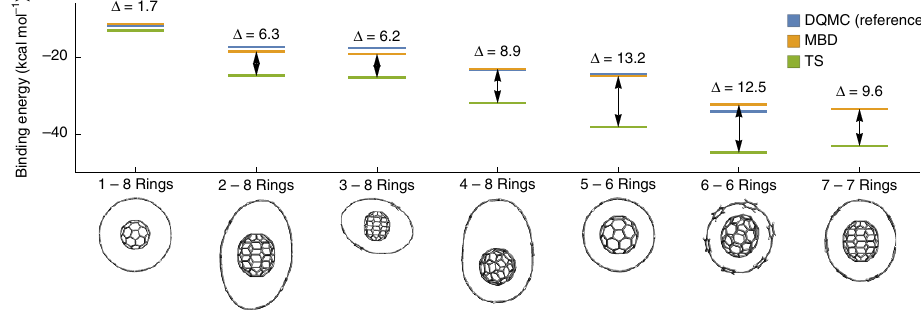
Figure 5 | Interaction energies of C70 in [ N ]cycloparaphenyleneacetylene (6 r N r 8). The sample was selected to cover a broad spectrum of geometrical motifs and hence the individual geometries are not necessarily energy minima. However, all geometries are stationary points of the potential energy surface. The energies are calculated with respect to relaxed fragments (see Supplementary Data 1). DQMC is the diffusion quantum Monte-Carlo method (not given for system 7), whereas MBD and TS are the MBD model and TS method calculated on top of the PBE functional, respectively. D denotes the energy difference between MBD and TS in kcalmol (cid:2) 1 . Numerical values are presented in Supplementary Table